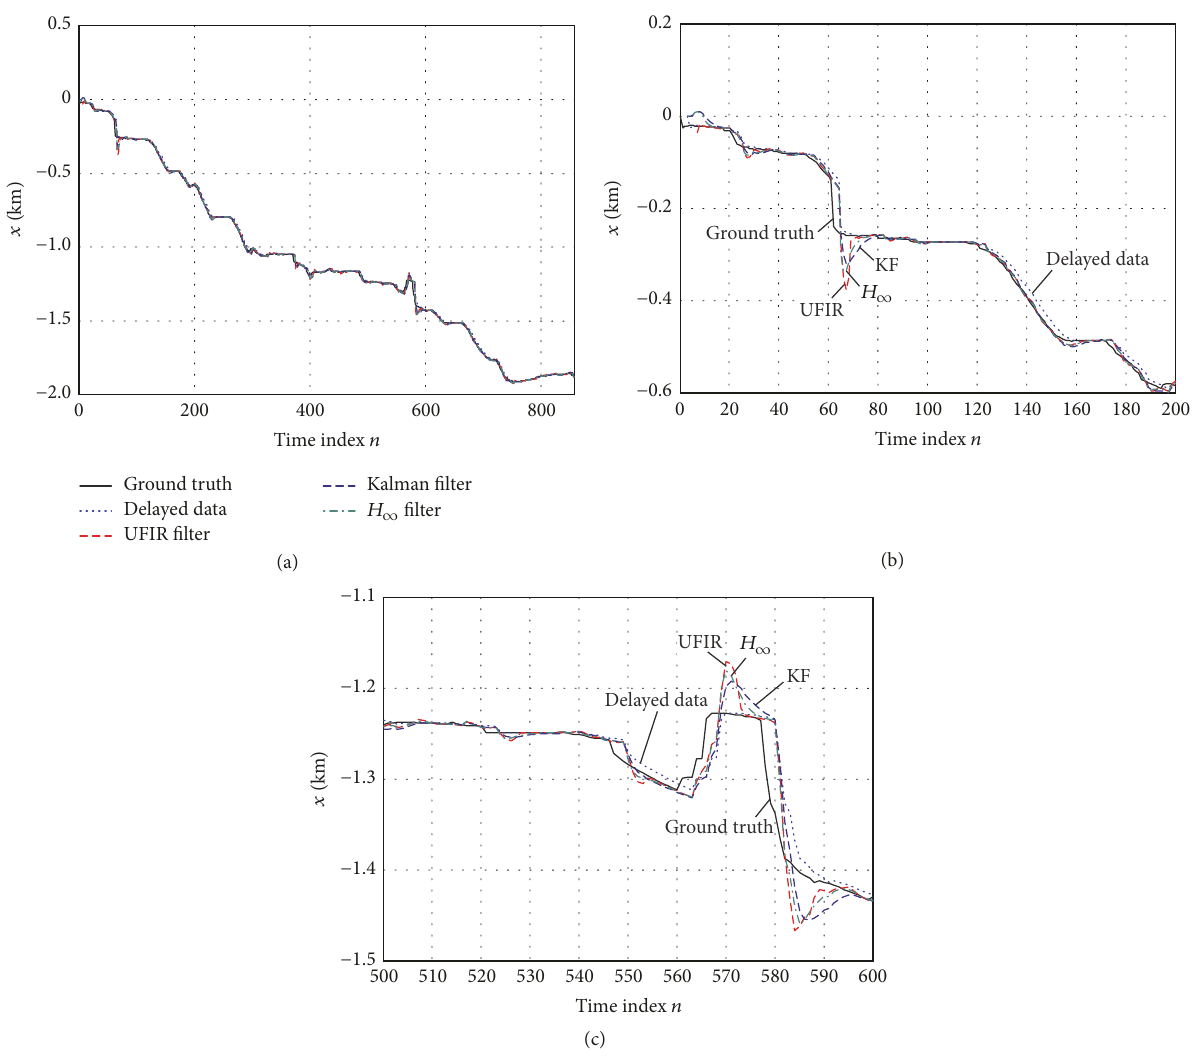
Figure 5: Tracking in the east direction 𝑥 , 𝑚 for 𝑘 = 3 with UFIR filter ( 𝑁 opt = 5 ), KF, and 𝐻 ∞ filter ( 𝜃 = 3.3 × 10 −4 ): (a) full time scale, (b) 0 ⩽ 𝑛 ⩽ 200 , and (c) 500 ⩽ 𝑛 ⩽ 600